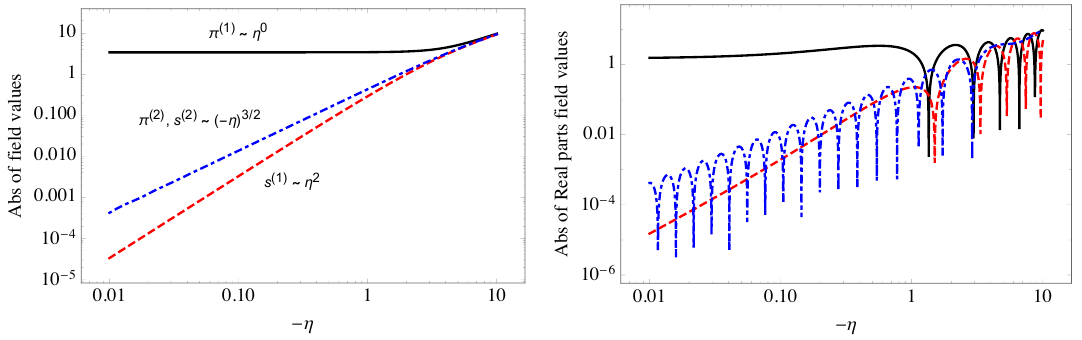
Figure 3 . Left: absolute values of the (cid:12)eld values with m = 2 H and (cid:22) = 10 H . The solid black and the dashed red curves are for the (cid:25) and s mode with the index (cid:11) = 0. The dot-dashed blue curve illustrates the (cid:25) and s modes whose dominant small (cid:0) (cid:17) behavior comes from the index (cid:11) = 3 = 2 (cid:6) (9 = 4 (cid:0) ( m 2 + (cid:22) 2 ) =H 2 ) 1 = 2 . Right: showing the absolute value of the real parts of each mode corresponding to the ones in the left